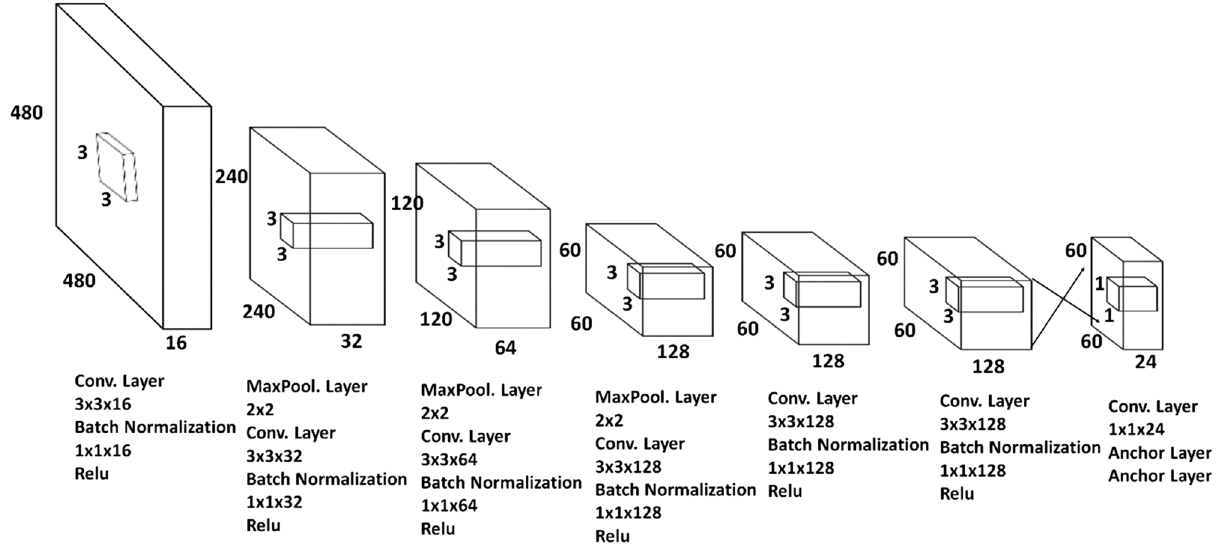
Figure 5. Architecture of the proposed YOLOv2 network framework. The input image has a size of 480 × 480, and each layer is reduced by filters of up to 60 × 60. All combinations of the network architecture blocks have a convolution layer, Batch normalization and Relu, with the exception of the last layer that presents the exit through convolution and the anchor boxes. Only the three initial layers have Max pooling.